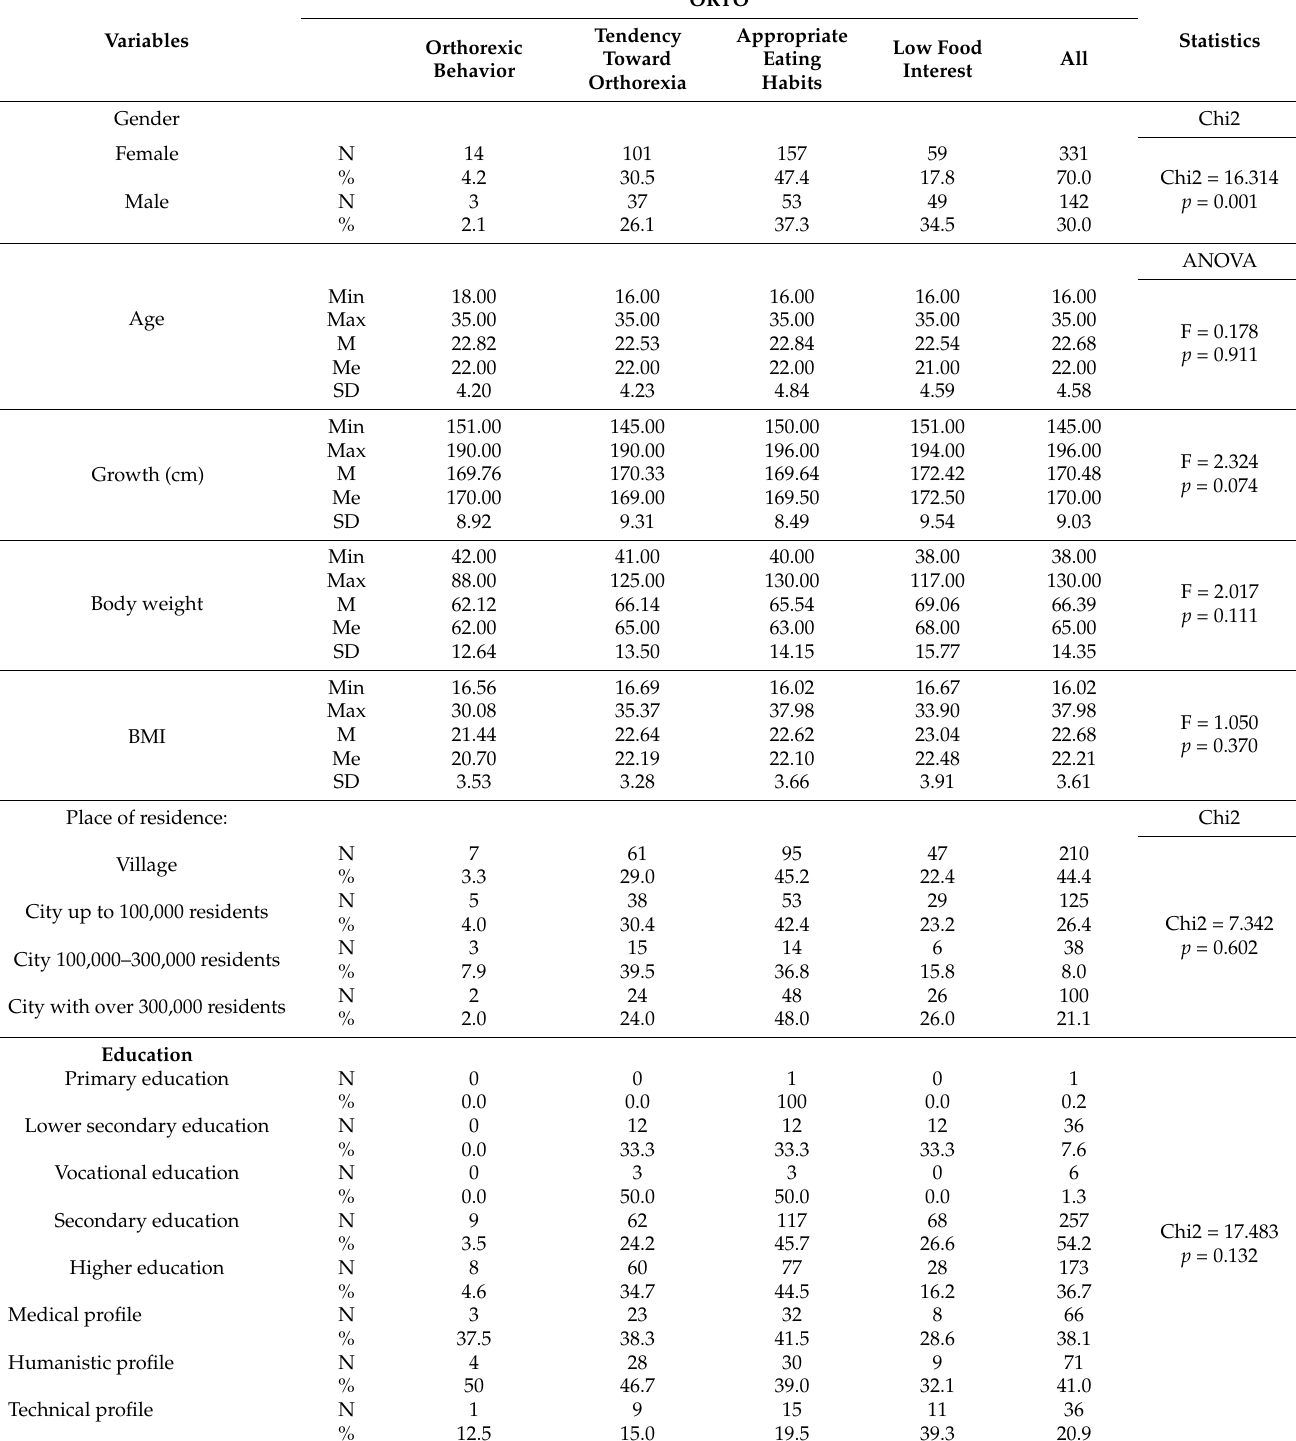
Table 1. Characteristics of the study